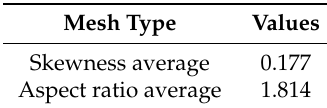
Table 5. Mesh quality check results for the fine mesh type.